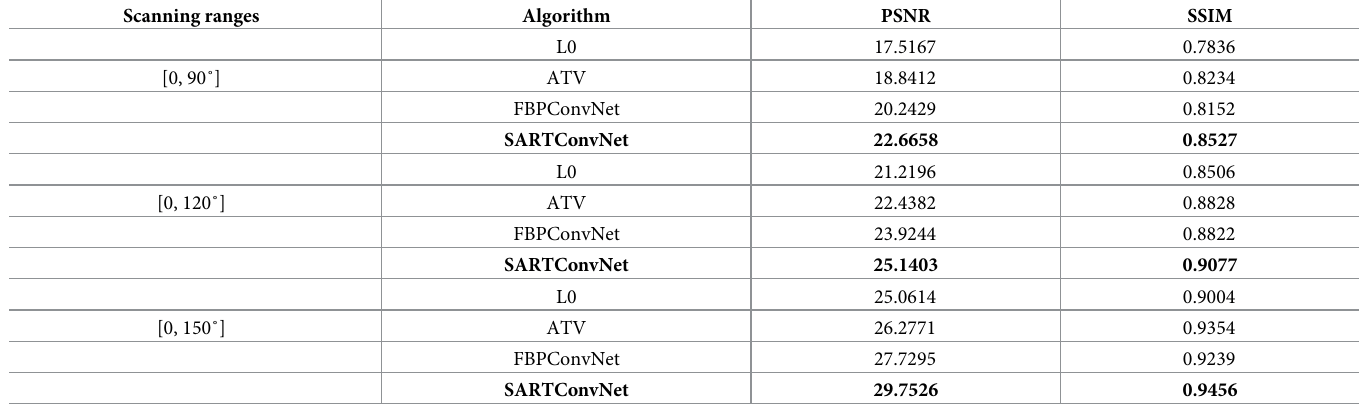
Table 4. Quantitative results associated with different algorithms for the abdomen image from different angle noise-add projection data. Scanning